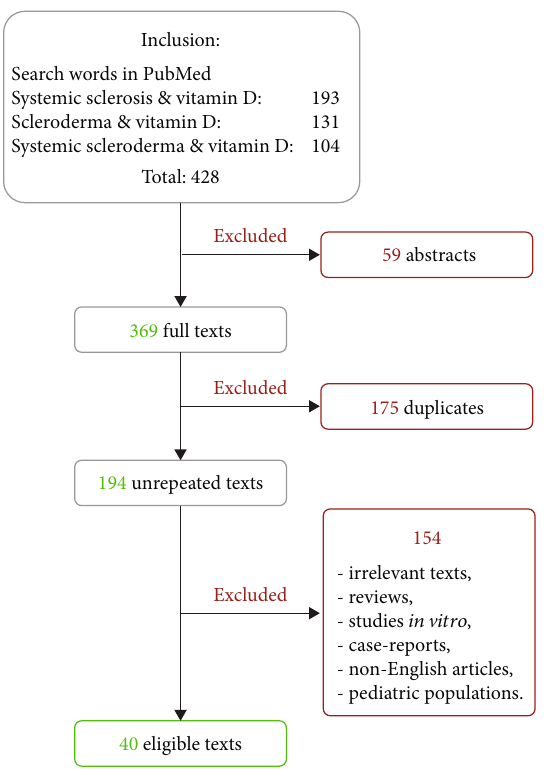
Figure 1: Flowchart of study